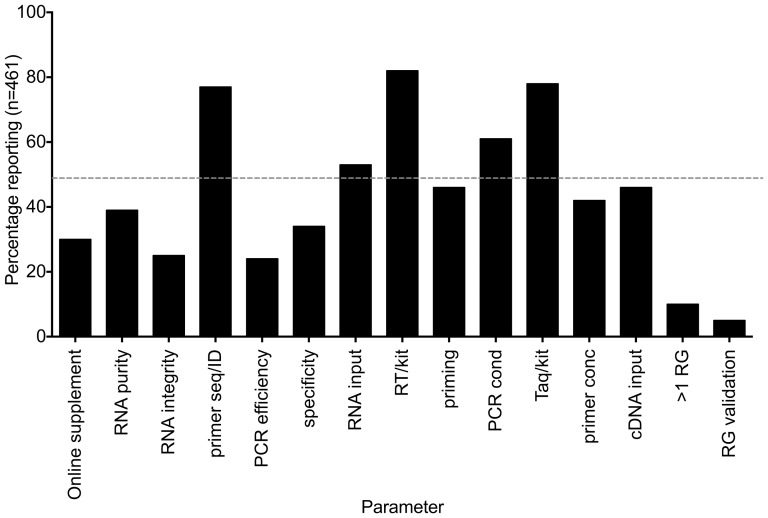
% compliance with 15 MIQE parameters by all 461 publications between 2009 and 2013.The hatched grey line indicates 50% compliance.